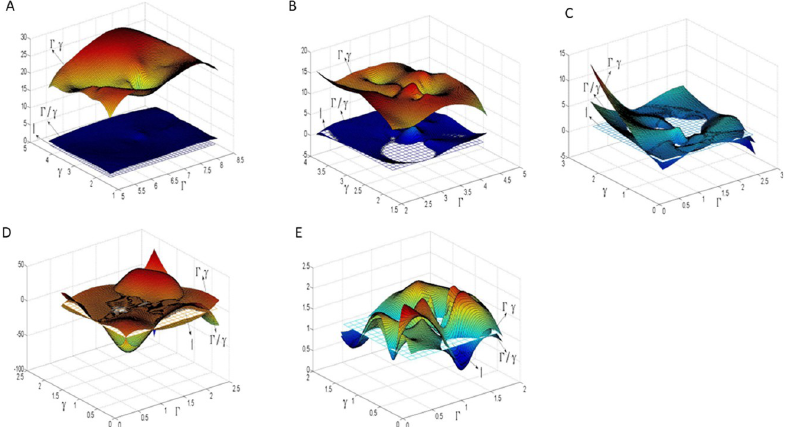
Fig 10. 3D fitted surface on the singular values and their relation of Jacobian matrix in parameterization on balls model. (A) by LABF; (B) by LQHP; (C) by IQCP; (D) by QCTM; (E) by our method.